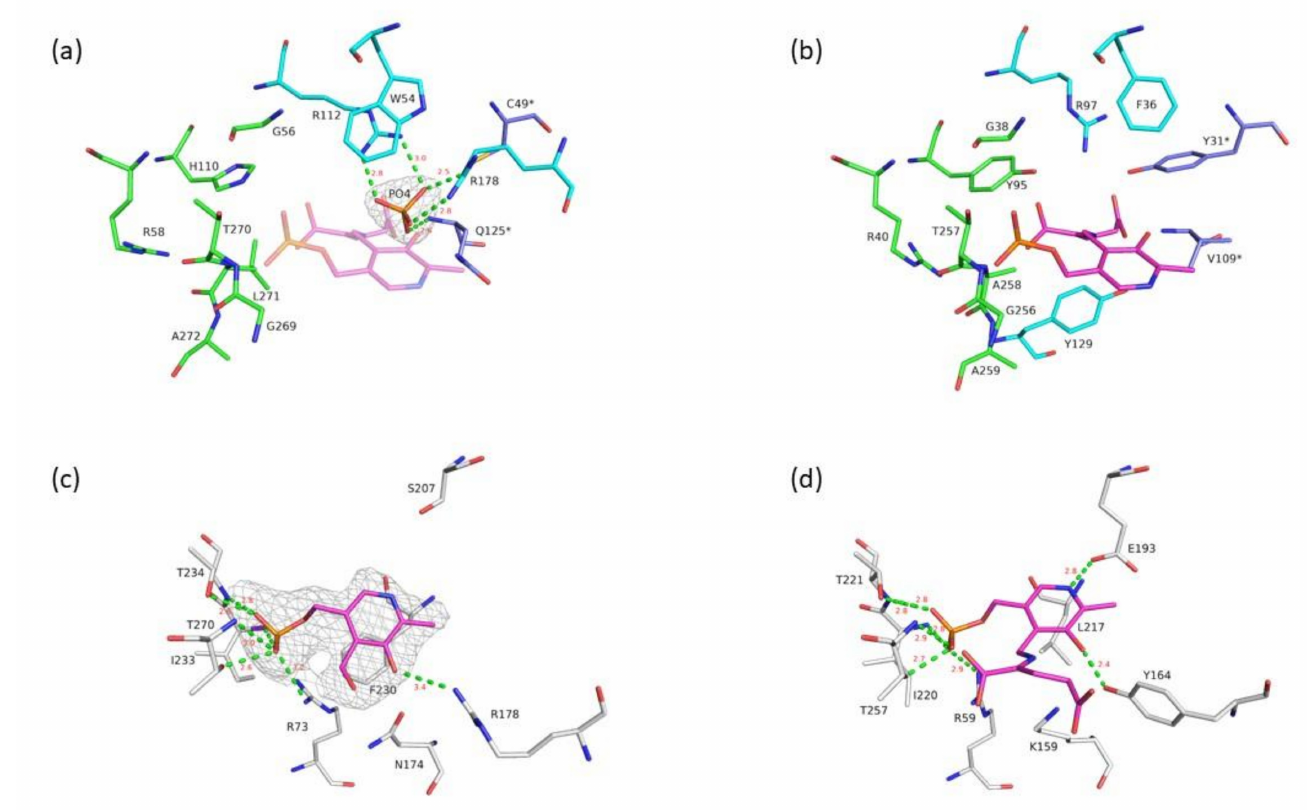
Figure 4. Active site comparison between VP5454 and eBCAT. ( a ) VP5454 active site. For clarity, only the residues described in the text are shown. P-pocket residues are colored in green, O-pocket residues in cyan, and residues of the O-pocket related to the adjacent subunit of the dimer are in blue. Omit F o -F c electron density map (gray mesh) for the phosphate molecule is depicted at 4 σ level. Hydrogen bonds fixing phosphate are shown with green lines, and corresponding distances are labeled in red. A PLP molecule with bound L-glutamate from superimposed eBCAT (PDB ID-1IYE) structure is shown in pink and is semitransparent for clarity. ( b ) eBCAT active site. Color codes and orientation is the same as in panel ( a ). Cofactor covalently bound to L-glutamate is shown in pink. ( c ) A PLP molecule bound in the VP5454 active site. Hydrogen bonds fixing PLP are shown with green lines, and corresponding distances are labeled in red. Polder map for PLP is shown as gray mesh at 4 σ level. Only one conformation of the F230 side chain is shown for clarity. ( d ) PLP coordination in eBCAT. PLP molecule covalently bound to L-glutamate is shown in pink. Orientation and color scheme is similar to that in panel ( c